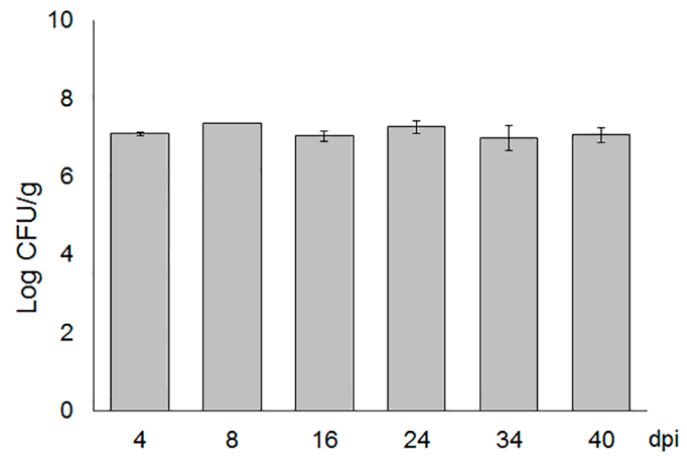
Figure 1. Trichoderma asperellum viability in the growing media. T. asperellum CFU per gram was quantified at various times after mixing with the growing substrate. The population was expressed as Log CFU/gram- Bars indicated SD from three independent experiments.